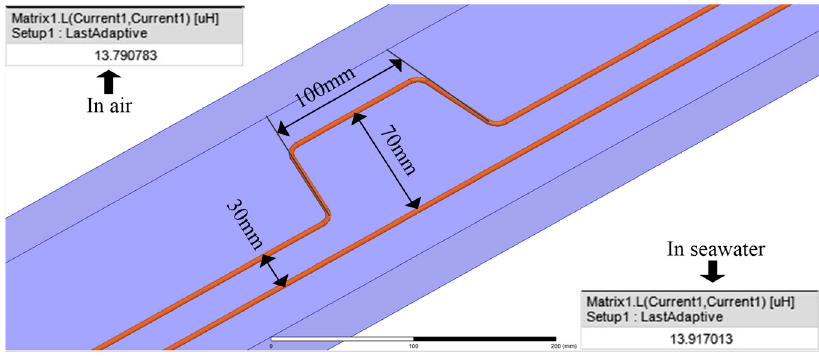
Figure 6. Simulations of the mooring cable’s inductance.